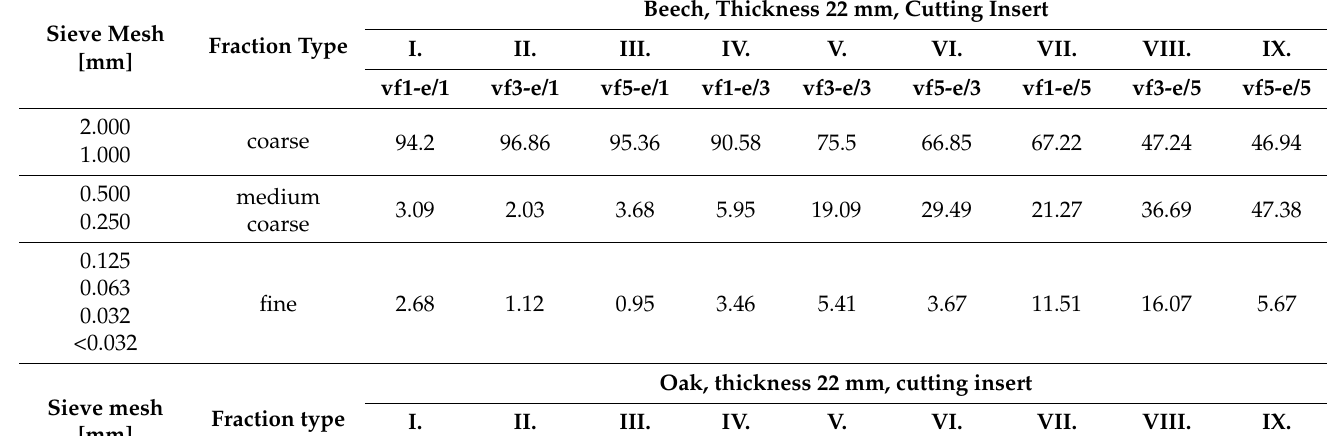
Table 5. Average particle size distribution according to individual combinations of monitored parameters: depth of cut, e, feed speed,